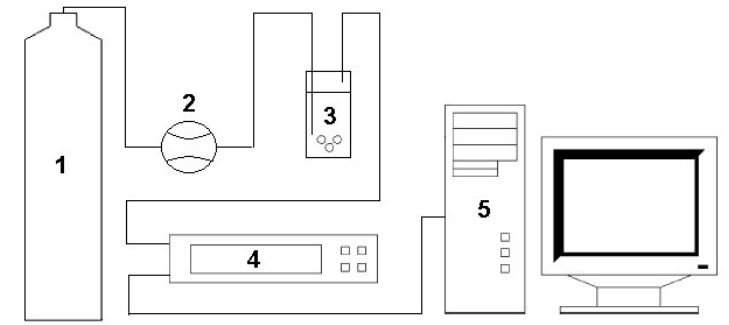
Figure 1. Experimental set-up for analysis of volatile fraction of reference gaseous mixtures consisting in: 1—bottle with carrier gas, 2—flow meter, 3—scrubber, 4—prototype of electronic nose,